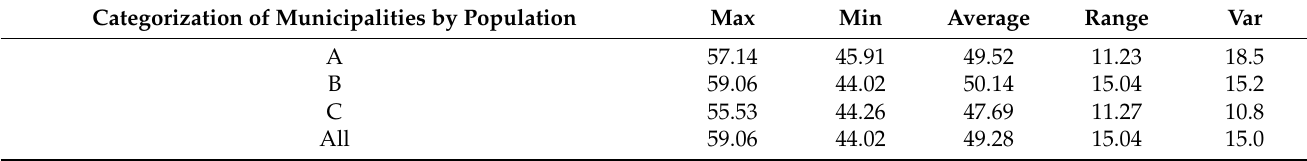
Table 7. The value of the Quality of Life Synthetic Index for different categories of Cittaslow municipalities. Categorization of Municipalities by Population Max Min Average Range Var